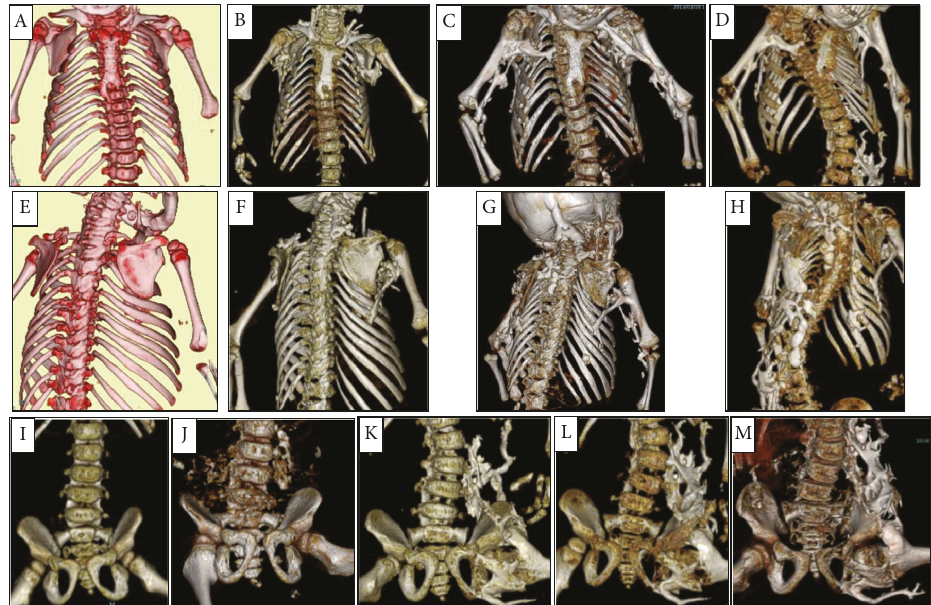
Figure 2: Time-course series of heterotopic ossification (HO). (a–d) Front chest and upper limbs. (e–h) Back chest. (a, e) At 10 months of age, HO was not observed. (e) Cervical vertebrae fusion was observed. (b, f) At 26 months of age, HO was observed from the bilateral axillary and humerus. (c, g) At 42 months, HO was observed between the humerus and radius and between the humerus and thoracic cage. (d, h) Scoliosis due to multiple HO occurrences was observed at 106 months. (i–m) Lumbar spine and pelvis. (i) At 26 months of age, HO was not observed. (j) At 42 months of age, HO was observed from the left transverse process of the lumbar spine. (k) At 78 months of age, HO was observed from the neck of the left femur and connected the left transverse process and left femur thereafter. (l) At 106 months of age. (m) At 121 months of Table 1: Clinical characteristics of severe FOP patients with the heterozygous p.Arg258Gly variant of ACVR1.